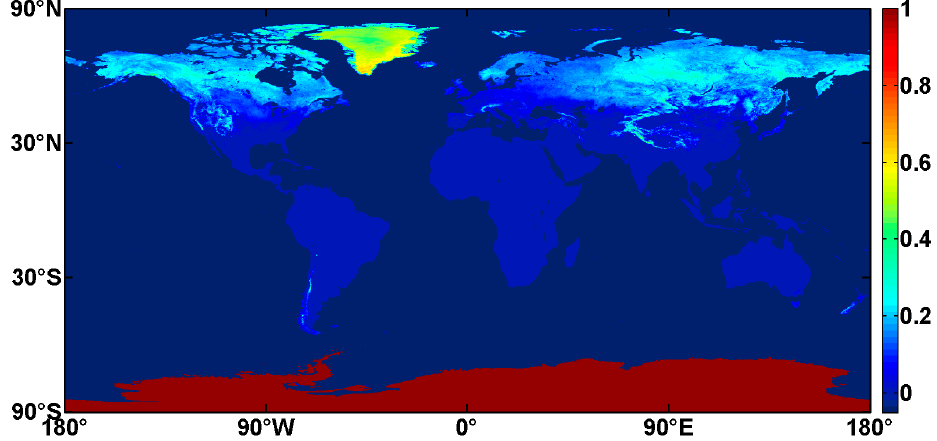
Figure 2. Spatial distribution of mean fractional snow cover during 2003–2016.